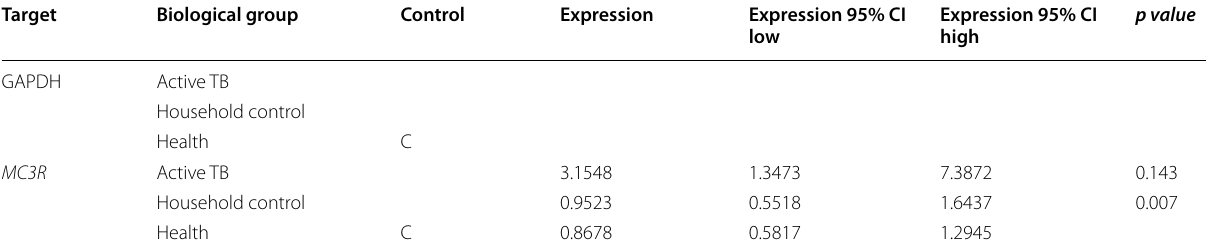
Table 2 Gene expression values in active TB, household contact, and healthy controls